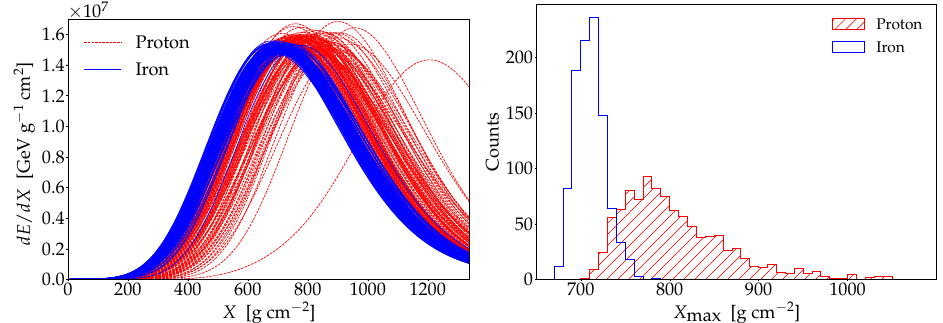
Figure 2. Left : Simulated longitudinal profiles for proton- and iron-initiated air showers. Right : Depth of the shower maximum distributions for proton- and iron-initiated air showers. The primary energy is E = 10 19 eV and the zenith angle is θ = 40 ◦ . The simulations are performed with